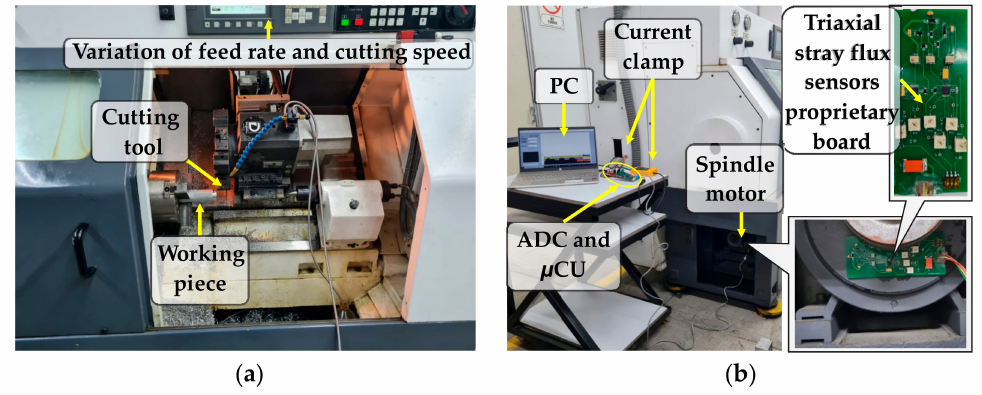
Figure 7. Experimental setup: ( a ) machining process and ( b ) data acquisition system module.